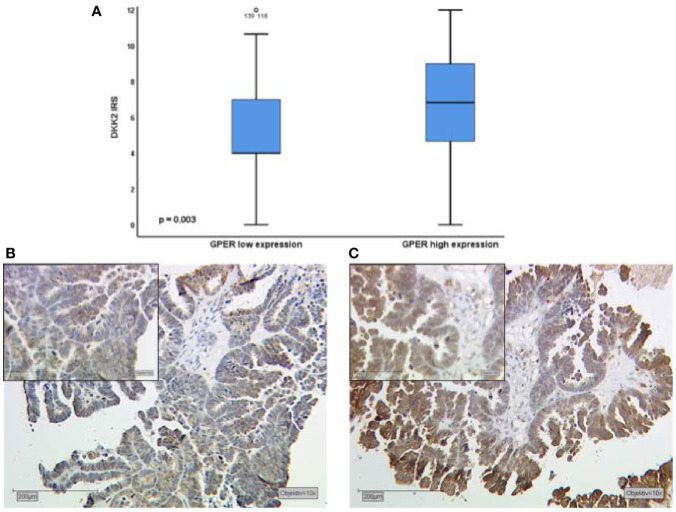
Kruskal-Wallis analysis for correlation of Dkk2 and GPER expression (A). High expression of Dkk2 (B) correlates with high GPER expression (C) in tissue samples of the same patient. Scale bares equal 200 μm.